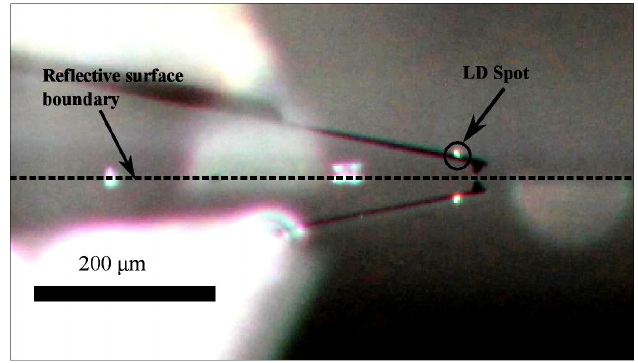
Figure 5. Microcantilever SHOCONA with the reflecting laser spot from the OFI